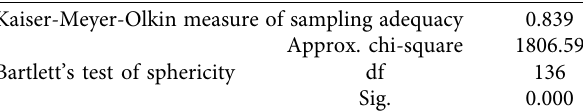
Table 4: Kaiser-Meyer-Olkin (KMO) and Bartlett’s